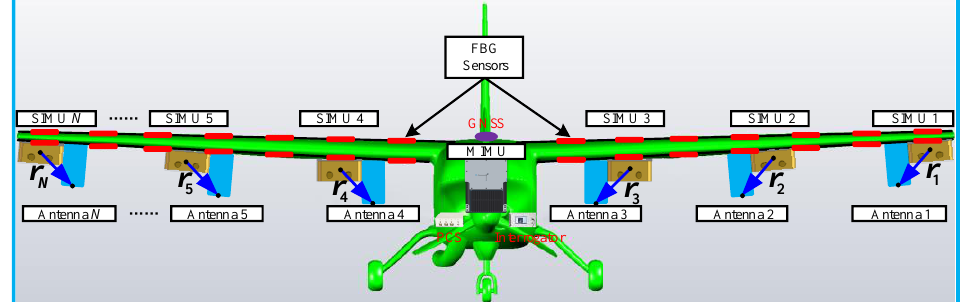
Figure 7. Rigid lever-arm between SIMU and SAR antenna.